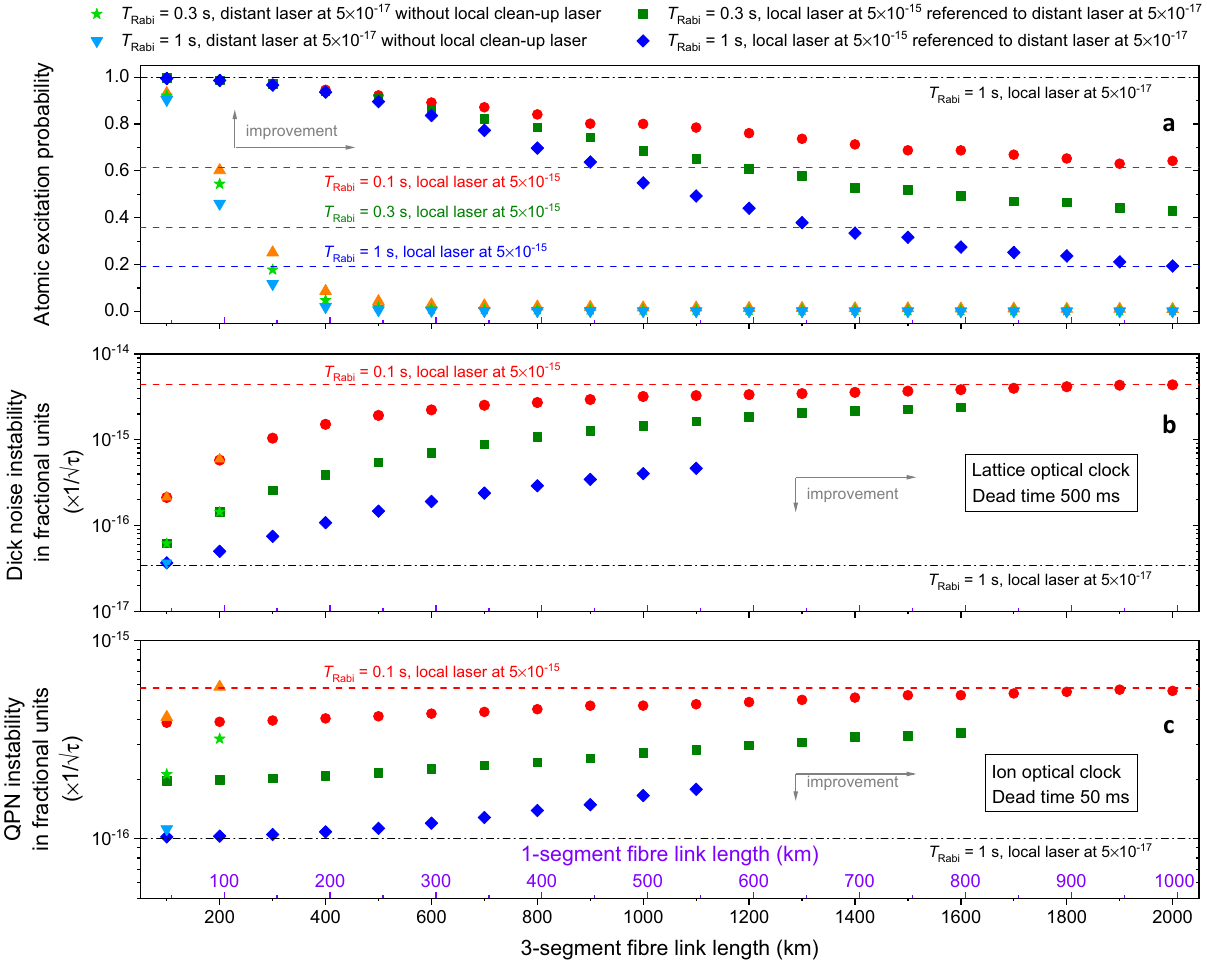
Fig. 5 Estimated atomic excitation probability and instability of an optical clock receiving light from a distant ultrastable laser as a function of the optical fi bre length. a Simulated excitation probability of a hypothetical optical clock at the user ’ s location as a function of the fi bre link length, with and without a local clean-up laser, for a Rabi interrogation time T Rabi of 0.1 s (red circles and orange upward triangles), 0.3 s (dark green squares and green stars) and 1 s (blue diamonds and cyan downward triangles). The error bars (see the “ Methods ” section) are within the size of the markers. b Instability of a hypothetical optical lattice clock (Sr lattice with clock transition at 698 nm) with 500 ms dead-time, with and without a local clean-up laser, for a Rabi interrogation time T Rabi of 0.1 s (red circles and orange upward triangles), 0.3 s (dark green squares and green stars) and 1 s (blue diamonds and cyan downward triangles). c Instability of a hypothetical ion optical clock (Yb ion with clock transition at 467 nm) with a dead-time of 50 ms as a function of the fi bre link length, with and without a local clean-up laser, for a Rabi interrogation time T Rabi of 0.1 s (red circles and orange upward triangles), 0.3 s (dark green squares and green stars) and 1 s (blue diamonds and cyan downward triangles). The error bars (see the “ Methods ” section) are within the size of the markers. In ( b ) and ( c ), points corresponding to an excitation probability <0.5 have been omitted as in practice an optical clock would not be able to reliably operate below this excitation